Question: Compose a caption that would accompany this figure in a paper.
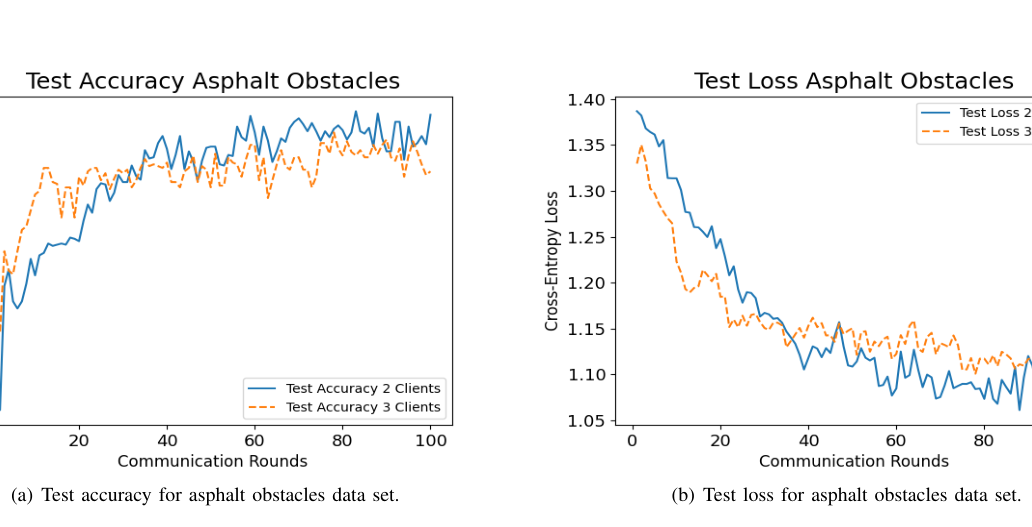
Answer: Performance of asphalt obstacles data set.